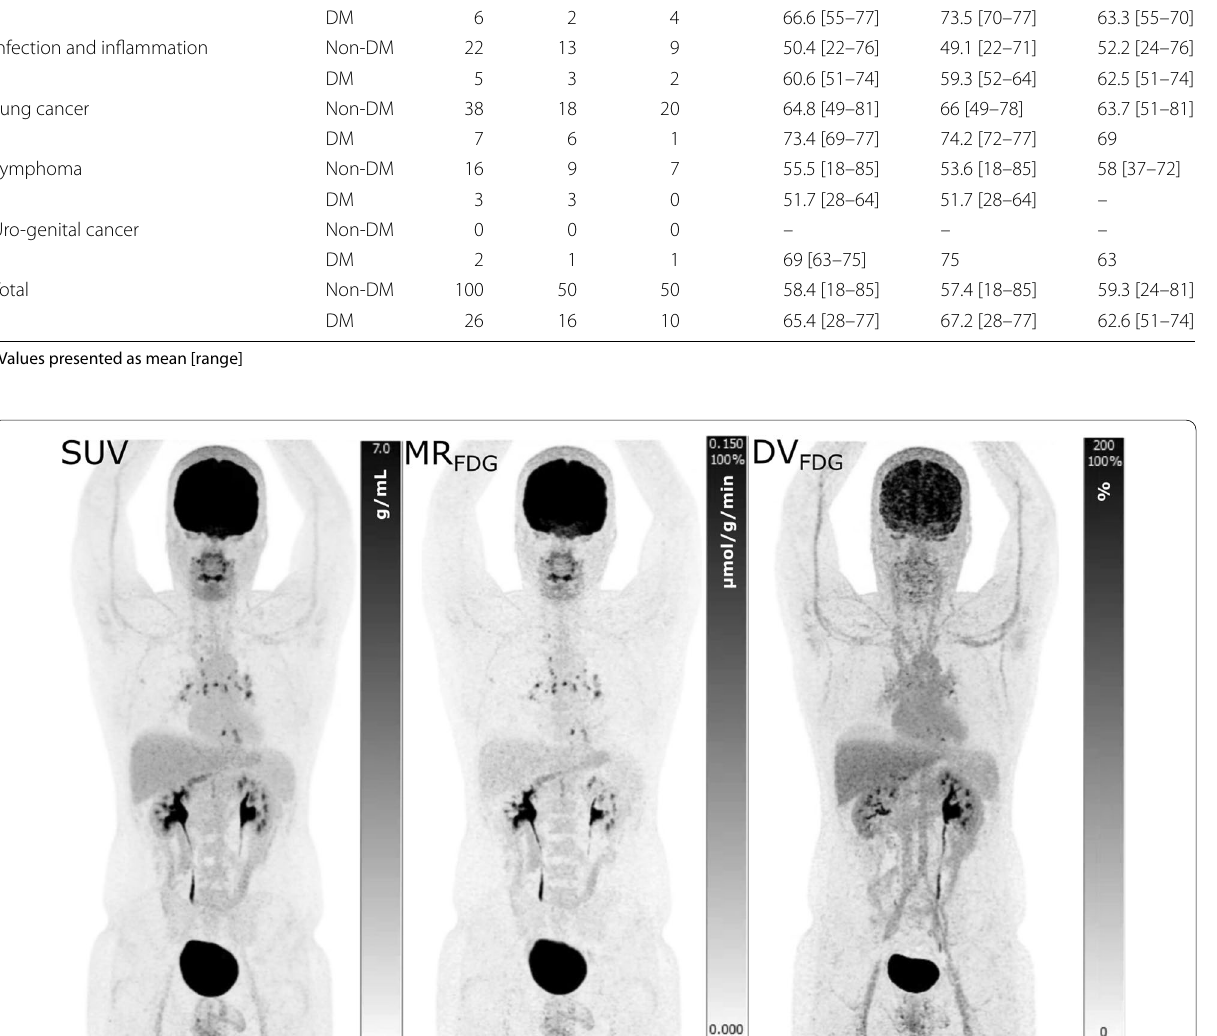
file 1: table S3 for a list of published values) and is not